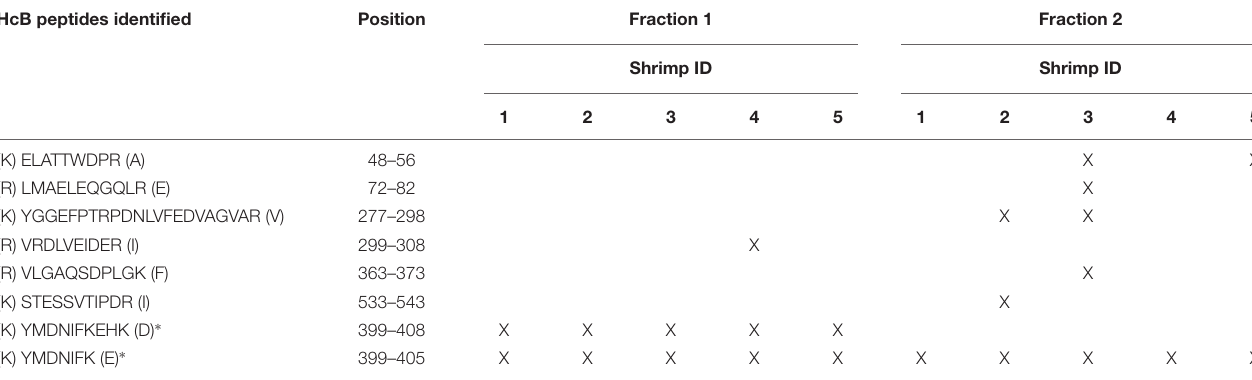
Fractions 1 and 2 collected from SE-HPLC separation represent dodecamer and hexamer fractions respectively. Amino acids enclosed in parentheses are sites of tryptic cleavage. Position values indicate amino acid residues based on the reference HcB sequence (Johnson et al., 2015). ∗ Denotes peptide shared by other hemocyanin